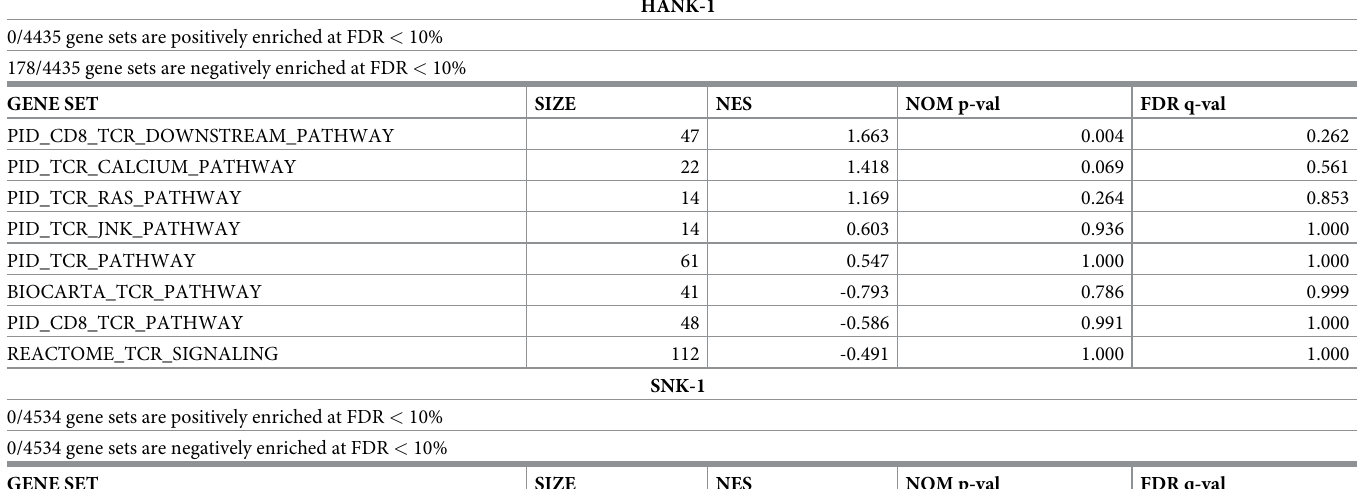
Table 1. Gene set enrichment analysis of siZAP-70 vs siNT in HANK-1, NKYS and SNK-1 NKTL cell lines [C2 gene set analysis].